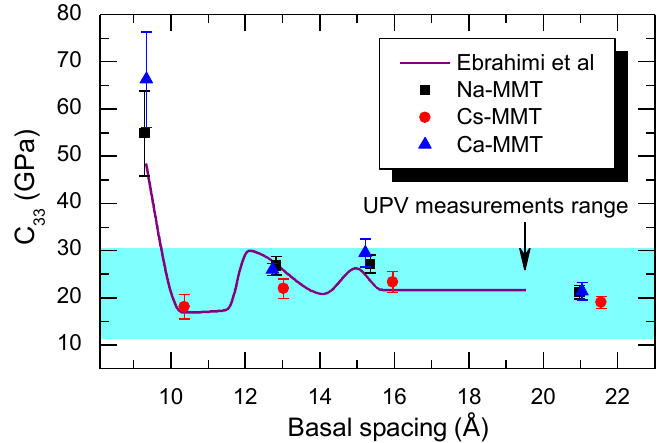
The evolution of elastic properties of hydrated MMT under different stable state water content will be further illustrated by analyzing the changes of some components in the stiffness tensor. To validate the study, the simulation results from [29] and UPV test results from [17] are adopted for comparison due to the high correlation with the work in this study. The authors in [29] gave the variation of stiffness components during the hydration process of Na-Wyoming MMT with a water content of 0–40%. The authors in [17] obtained the range of elastic stiffness constants of smectite minerals on the microscale based on UPV test results of clay composition in shale. For compression of clay under high pressure, the most concerning component of the stiffness tensor is C 33 , that is, the ability to resist deformation in the direction of perpendicular to the mineral plane. Figure 6 shows the variation of C 33 obtained upon hydration by [29], Na-, Cs-, Ca- MMT in this study under different stable state conditions, and the test range results of [17]. Since the stiffness tensor elements in this study are obtained by a statistical average of 20 frame trajectory files, the statistical standard deviation also given in Figure 6. of data is also given in Figure 6.